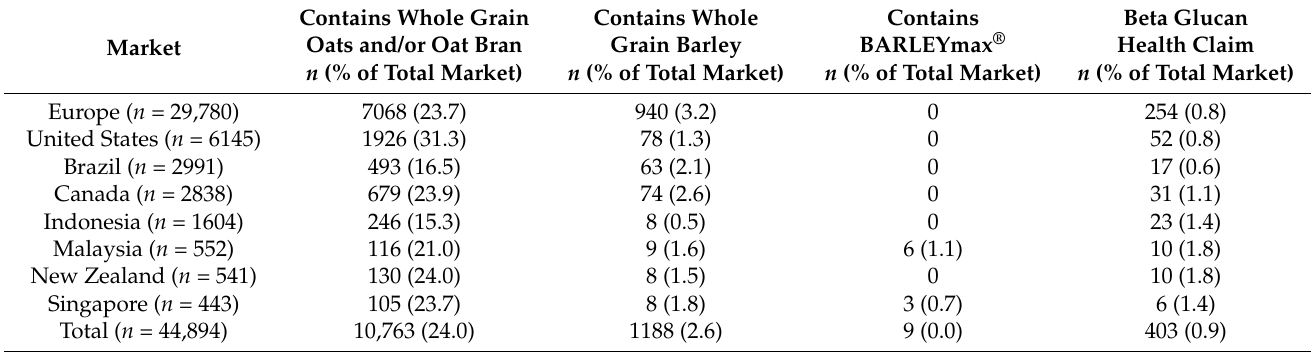
Table 4. Food and beverage products launched between January 2018 and September 2020, containing whole grain oats and/or oat bran, whole grain barley and BARLEYmax ® and use of beta glucan heart health/cholesterol-lowering health claims in selected